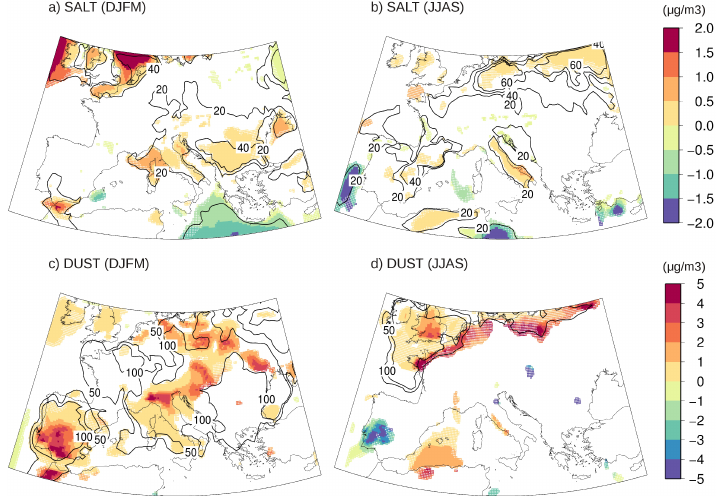
Fig. 5. NAO impact in winter (left) and summer (right) on mean ground levels of natural inert aerosols: NAO + minus NAO − composites for (a, b) SALT and (c, d) DUST. Differences in µgm − 3 are represented only if they meet the significativity criteria exposed in Sect. 3, dots blur the values not representing a signal-to-noise ratio above 1, and contours depict differences expressed as percentage. Period considered: